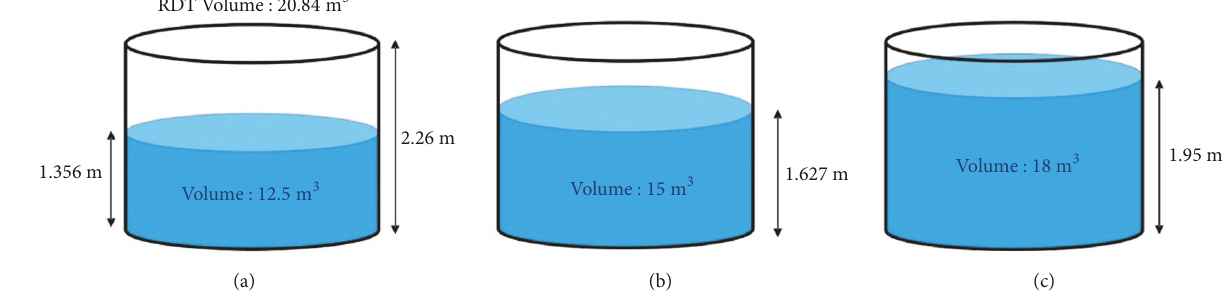
Figure 13: The different water volume in the RDT in each case: (a) 12.5 m 3 , (b) 15 m 3 , and (c) 18 m 3